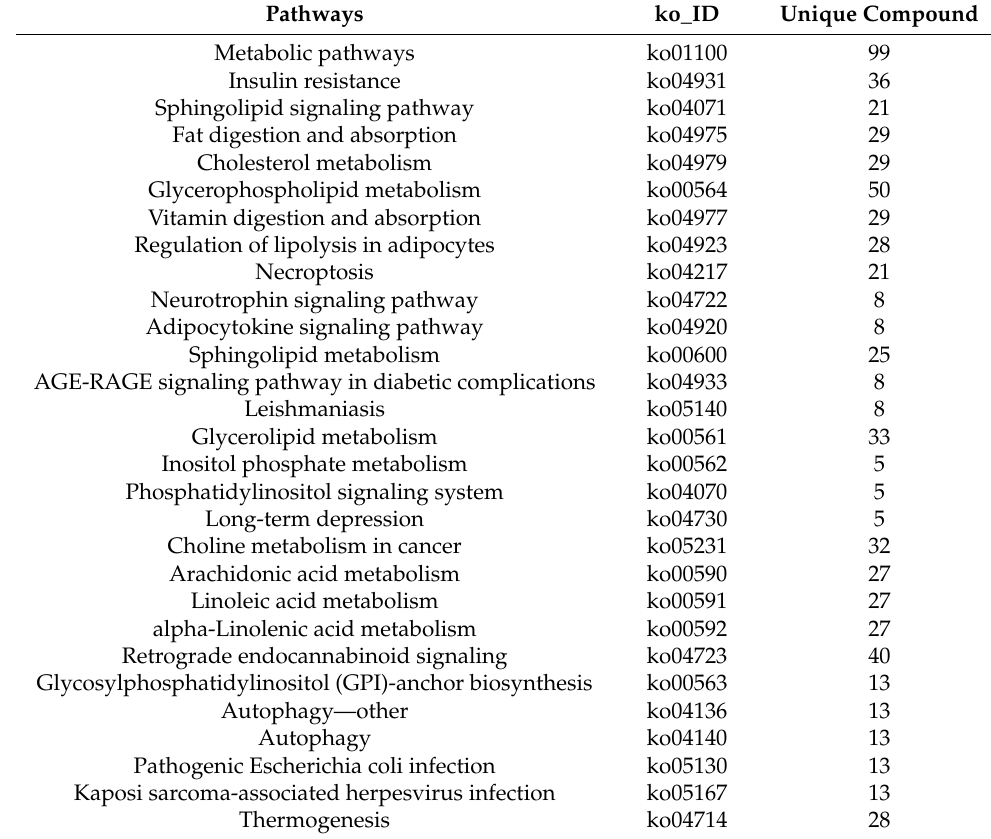
Table 10. Differential metabolic